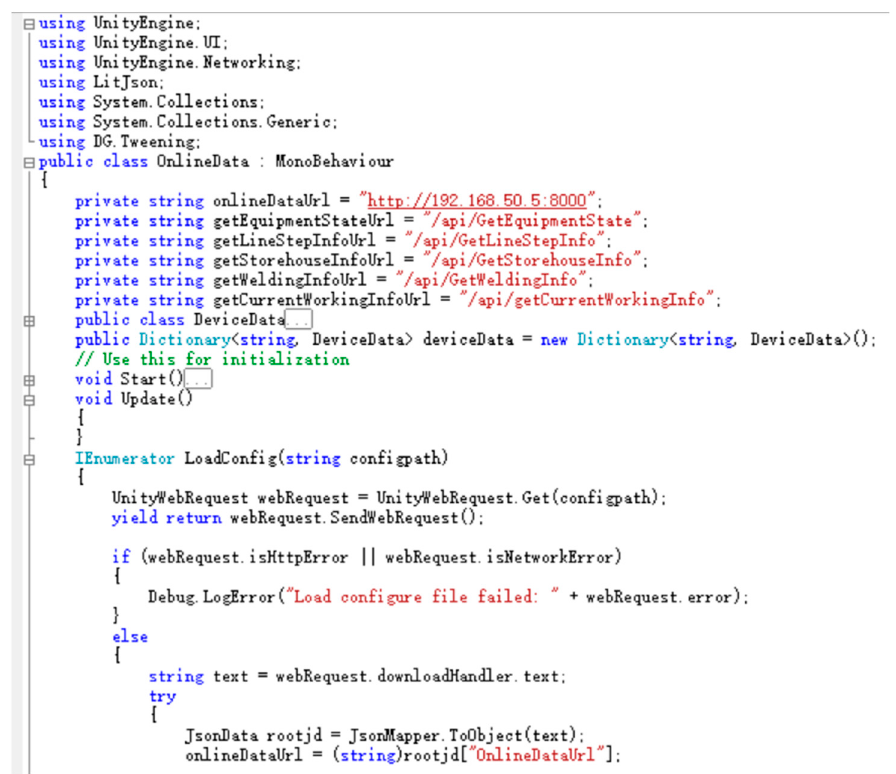
Figure 6. Example of online data acquisition background program of digital twin